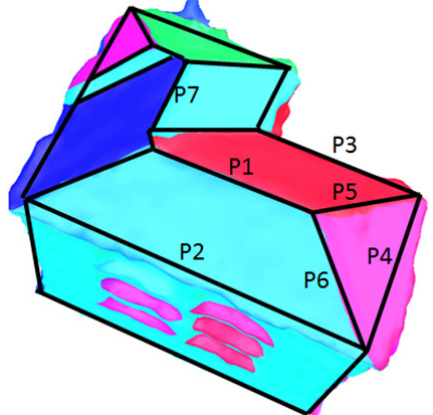
Fig.4. Straight skeleton refined by regularities